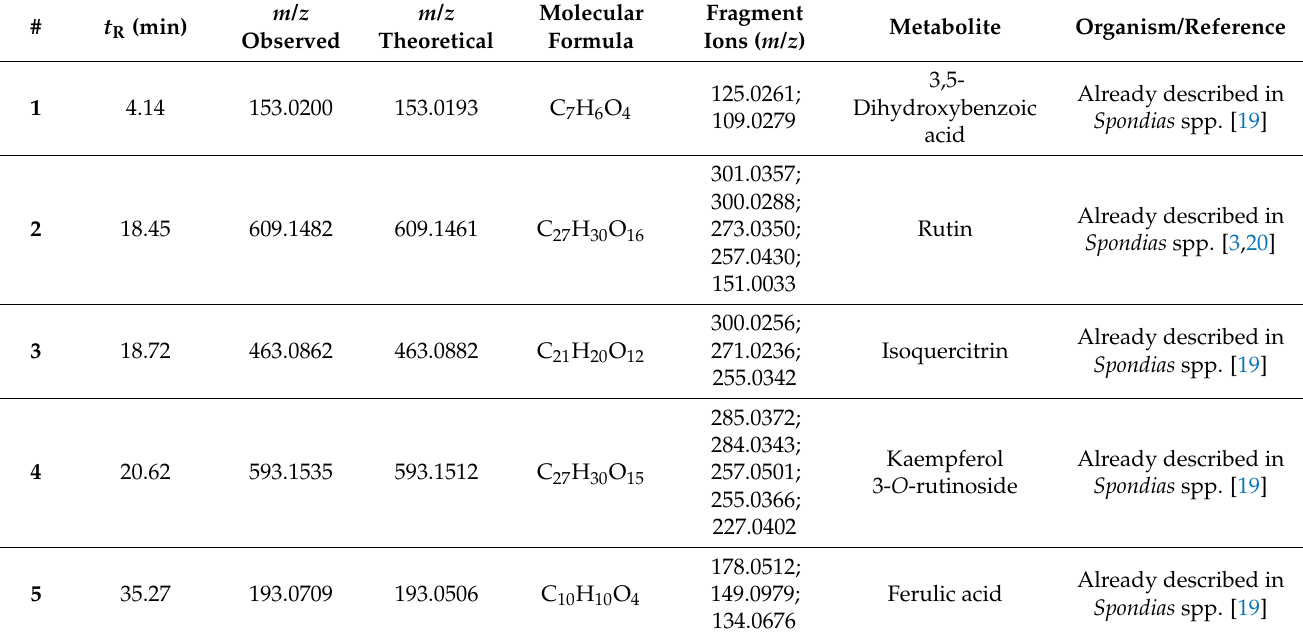
Table 2. Metabolites tentatively identified by LC-HRMS in negative ion mode.